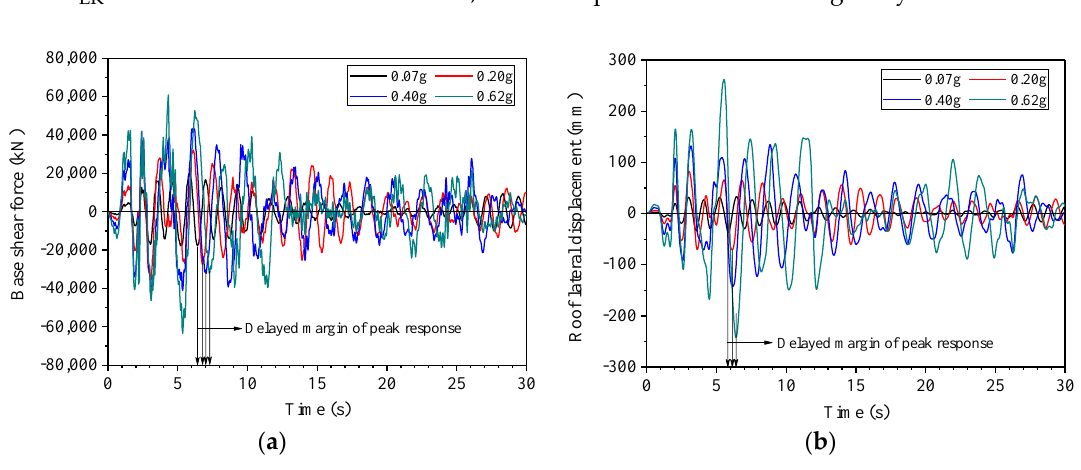
Figure 15. Time-history response curves subjected to different PGAs: ( a ) Base shear force; ( b ) Roof lateral displacement. Table 7. Base shear forces and shear-weight ratios under different earthquake intensity levels.